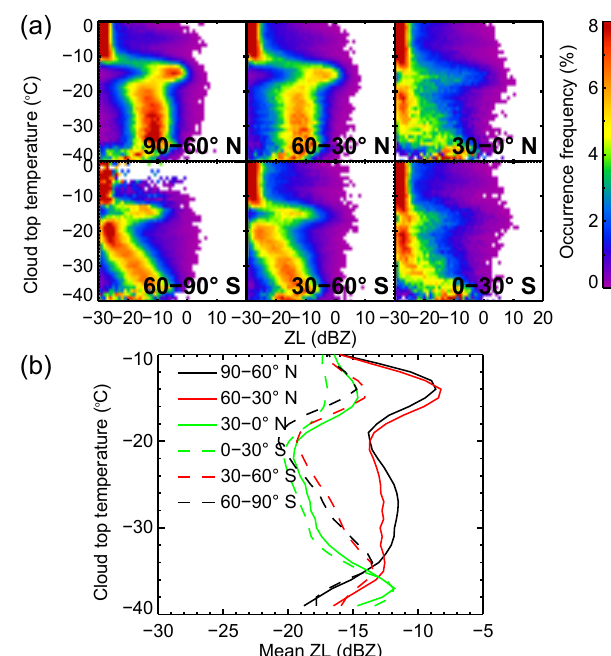
Figure 3. Global, annual-average, mid-level mixed-phase stratiform cloud ice production statistics. Results for six 30 ◦ latitude bands are shown covering the northern and southern tropical, mid-latitude and high-latitude regions. Cases are restricted so that the super- cooled liquid water path is within the range of 20 and 70gm − 2 . (a) Cloud distributions are in terms of cloud top temperature (CTT) and layer-maximum radar reflectivity (ZL), a proxy for ice produc- tion. (b) Mean ZL of clouds as a function of CTT. Distributions are normalized at each CTT bin. The bin sizes for CTT and ZL are 1 ◦ C and 1dBZ,